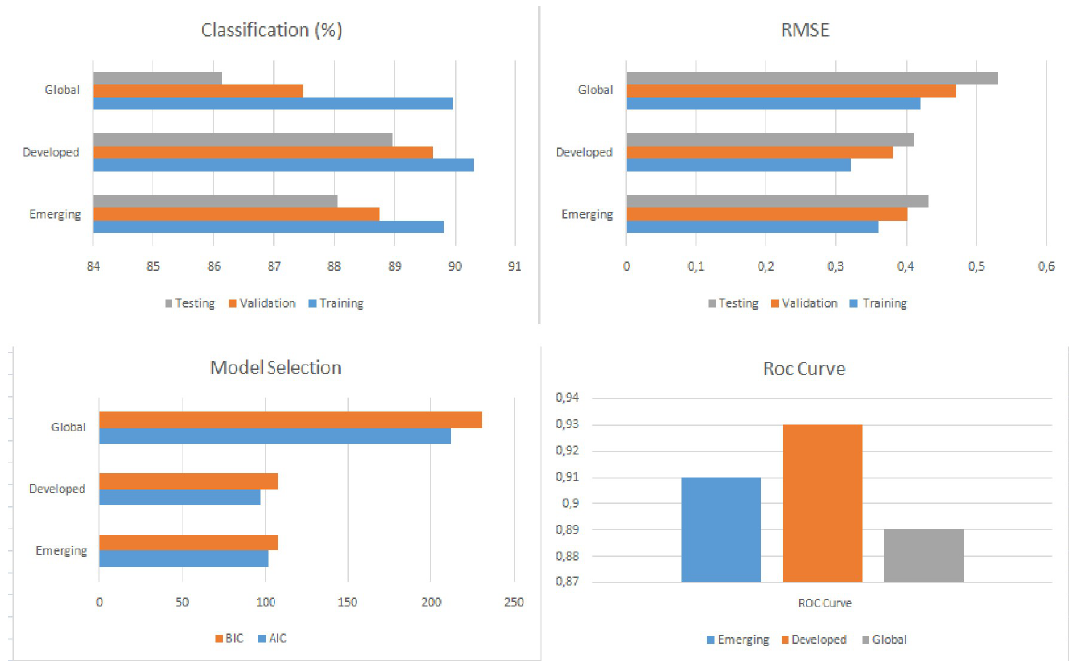
Fig 7. Results of accuracy evaluation for